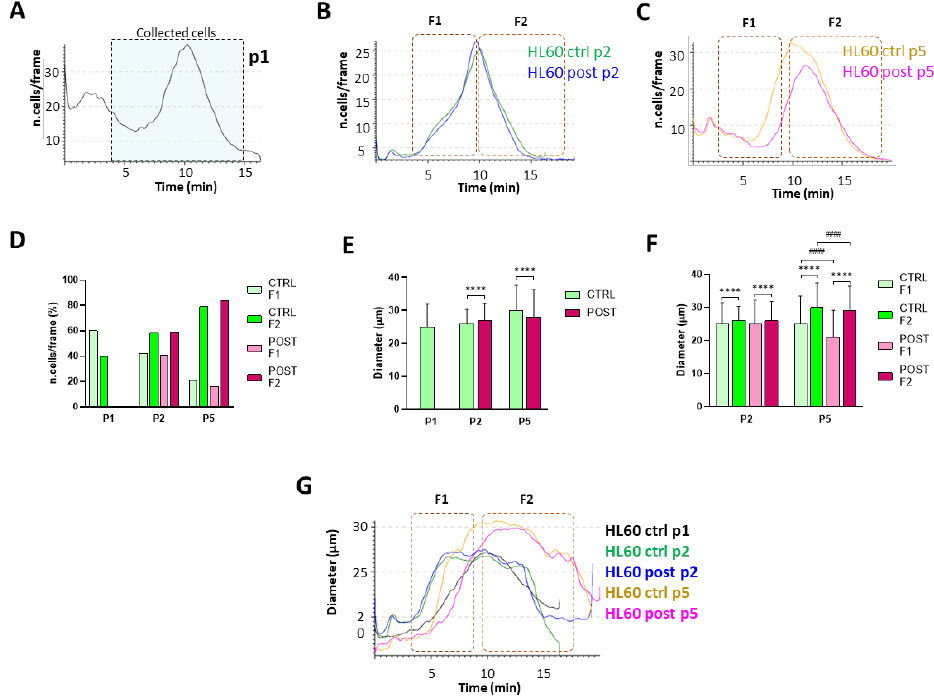
Figure 1. Celector analysis for HL60 cells. Fractogram of HL60 cells at passage 1 in culture and the collection time interval to exclude cell debris and dead cells, namely the void, including all elements that cannot reach the equilibrium and are immediately flushed out of the channel ( A ). The cell profile was monitored after in vitro culture for the CTRL cell population (ctrl) and for the collected cells (POST). After every enzymatic detachment, cells were analyzed for both conditions, and at p2 any differences were noticed ( B ), while at passage 5, the peak of the fractogram was shifted towards a higher elution time ( C ). The distribution of the percentage of cells during the analysis showed a difference in behavior during culture conditions, from a mostly homogenous situation to a higher presence of cells in the last eluate ( D ). The cell diameter was measured by post-processing image analysis, and CTRL cells showed an increase in dimensions during culture, while POST cells showed a slower increase in dimension with a statistically significant difference between the CTRL and POST cells ( E ). When the population was decomposed into 2 fractions, F1 and F2, CTRL cells showed a minor difference in dimension at p5 with F2 cells bigger than F1 cells, whereas POST cells showed the same trend but with a wider difference between the two fractions ( F ). One of the Celector ® outputs, as a post-process image, is the curve representing the average of dimensions as a function of time ( G ). Statistical analysis was performed using the 2way ANOVA test and mean and standard deviation were graphed (**** and #### p <